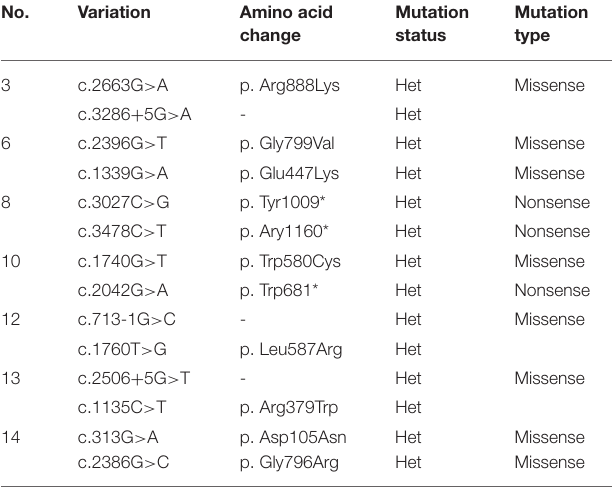
TABLE 3 | Variant locus analysis in patients with NPHS1 mutation.